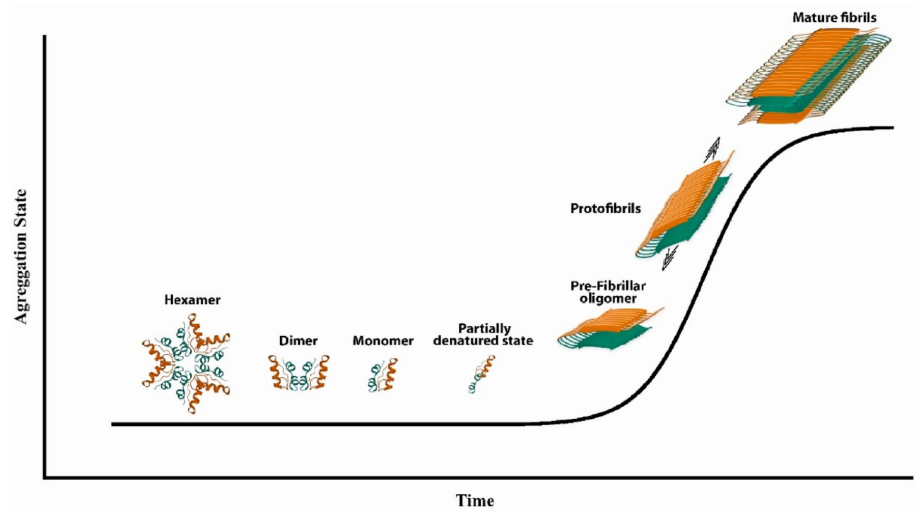
Figure 2. Scheme of insulin fibrillization. Reprinted from [21] with permission from Elsevier, Copyright © 2023 Elsevier.